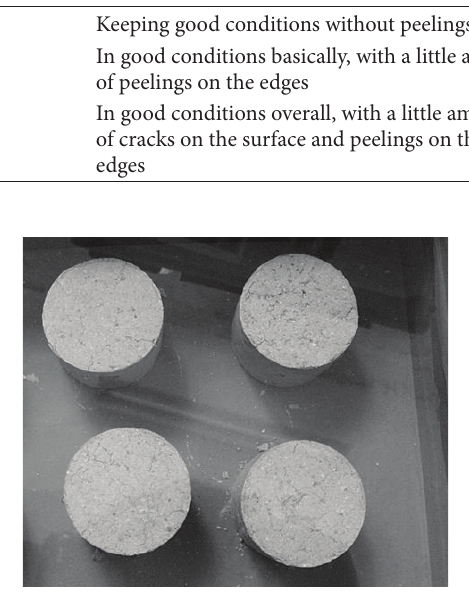
Figure 9: Improved samples immersed in water for 48h at 4th cycle of